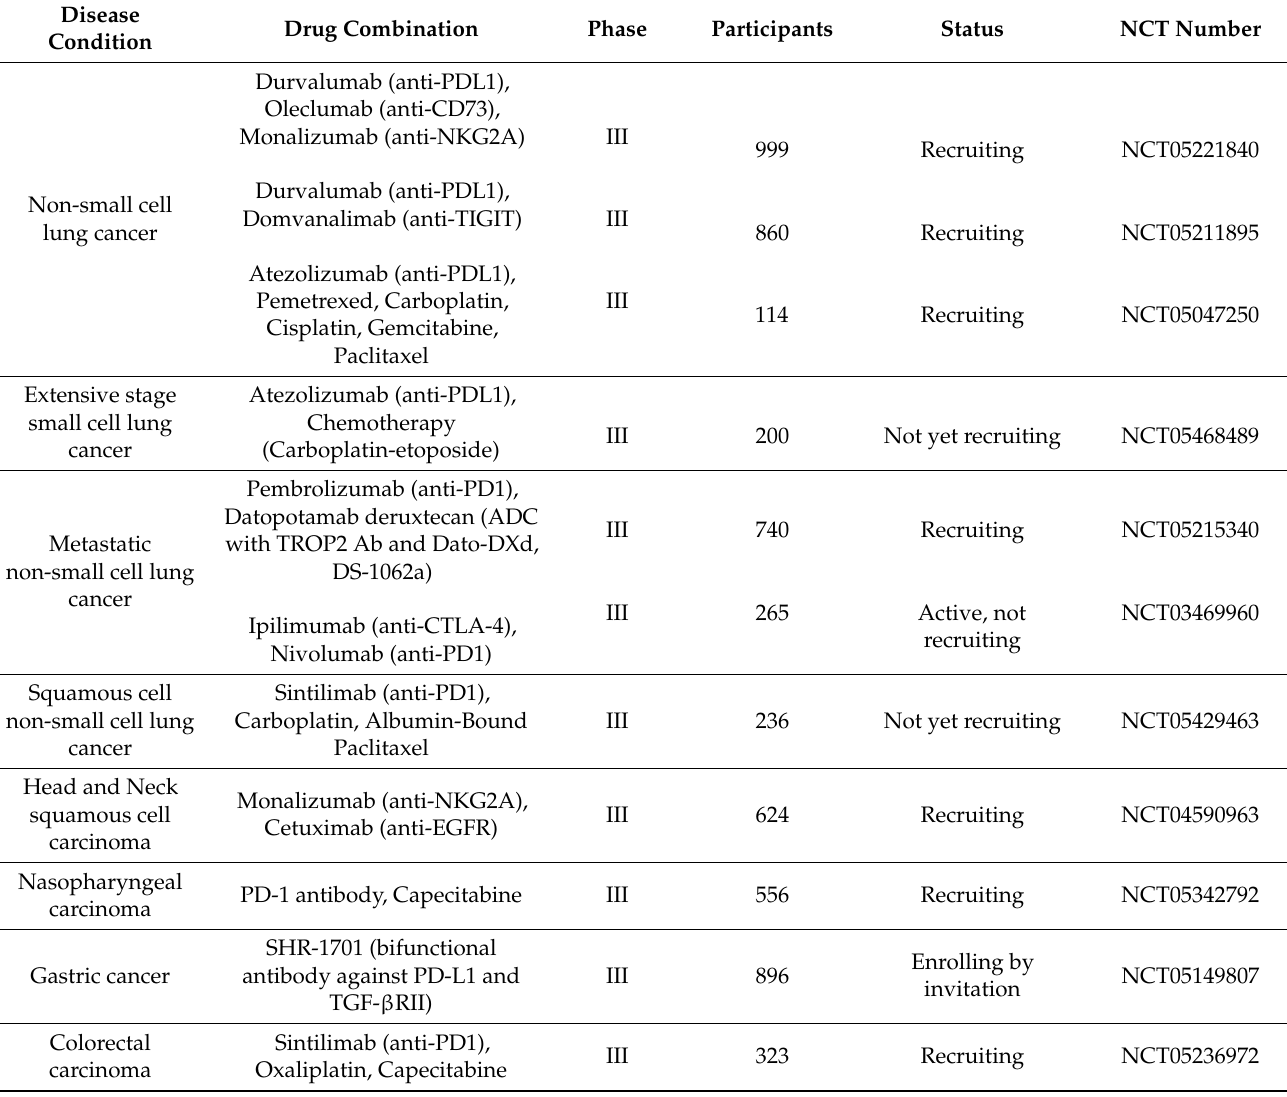
Table 1. Selected phase II/III/IV clinical trials of immune checkpoint inhibitor combinations in various human cancers. Data source ClinicalTrials.gov (www.clinicaltrials.gov, accessed on 25 June